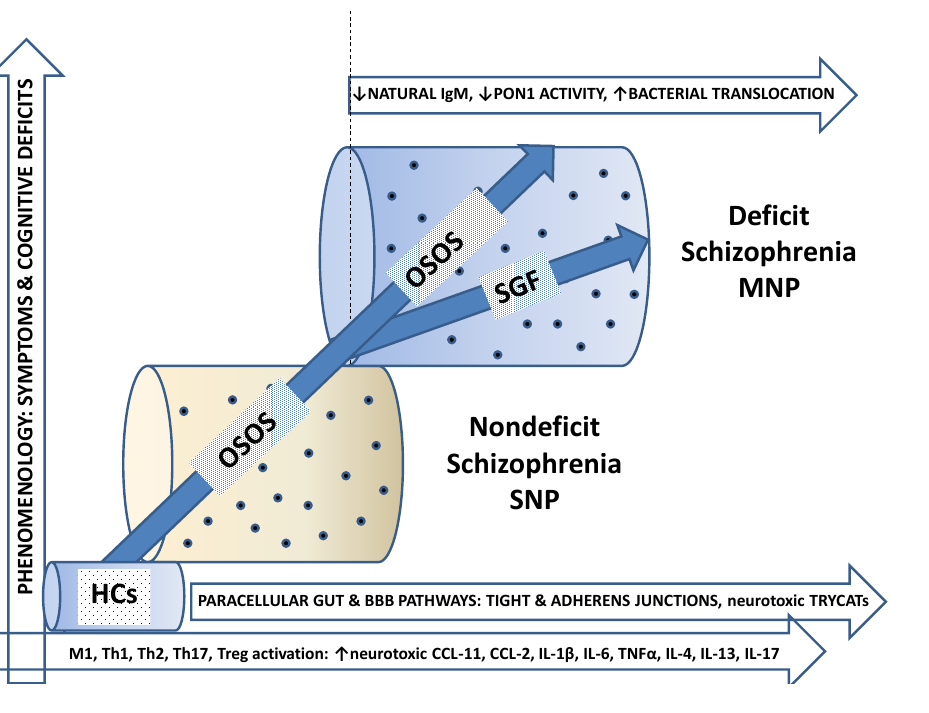
Figure 5. The bifactorial factor model, deficit and nondeficit schizophrenia. OSOS: General factor overall severity of schizophrenia; SGF: single-group factor; BBB: blood brain barrier; TRYCATs: tryptophan catabolites; M1 macrophage; Th: T helper; IL: interleukin; MNP: